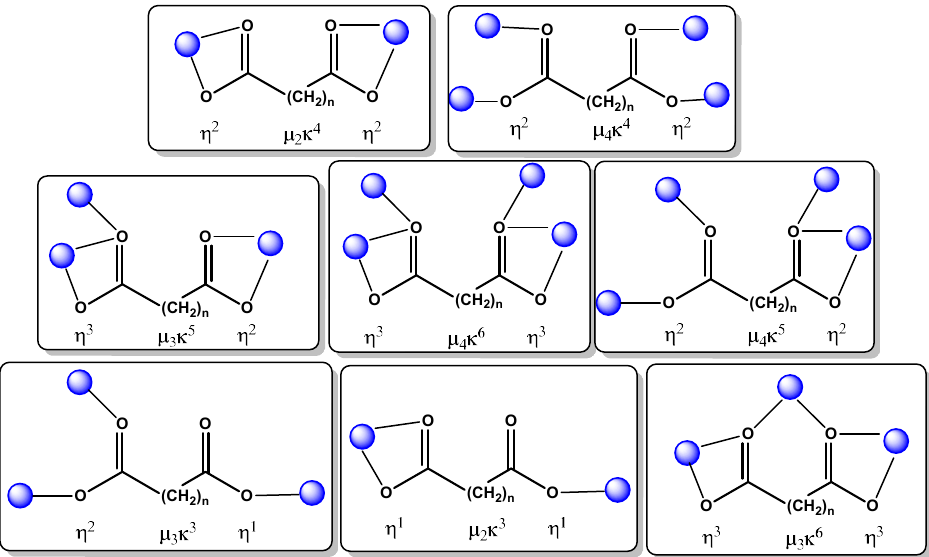
Figure 4. Typical coordination modes observed in ditopic aliphatic ligands.